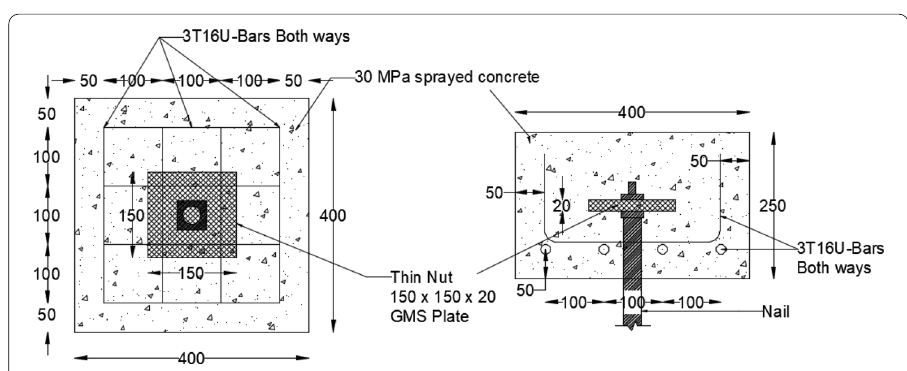
Fig. 2 Typical soil nail head detail (after CEDD drawing No.